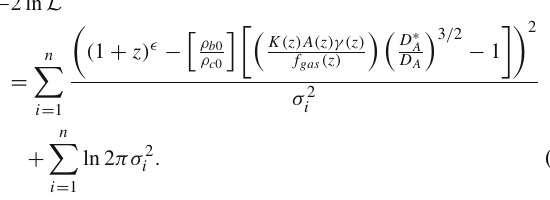
(cid:3) is shown in Fig. 2. We obtain: (cid:3) = − 0 . 234 + 0 . 159 − 0 . 171 which shows no interaction of dark matter with the dark sectors to within 1 . 4 σ . The evolution of the dark matter density ρ c ( z ) as a function of redshift along with the standard dark